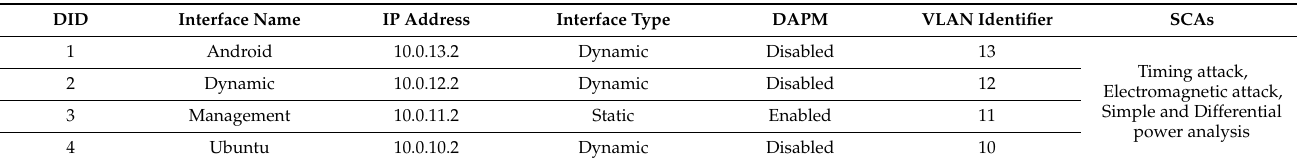
Table 3. Sampler Profiling Data